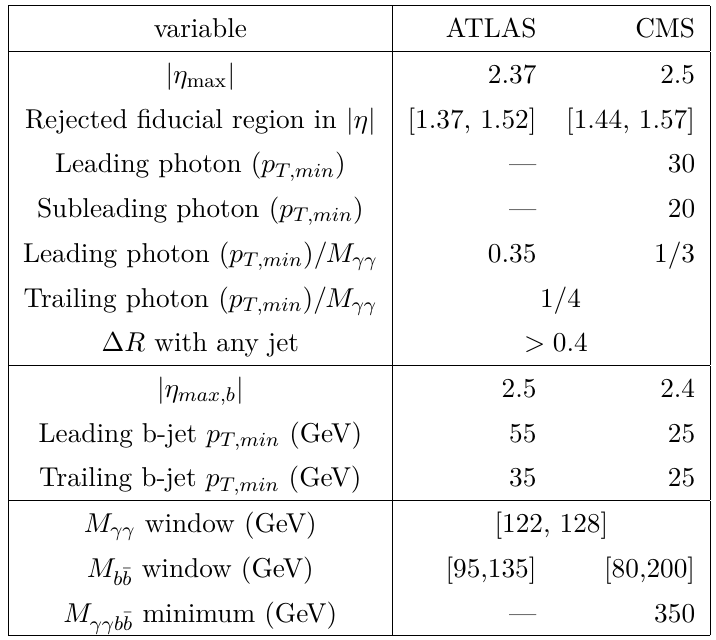
Table 2 . Selections used in the recast analyses.